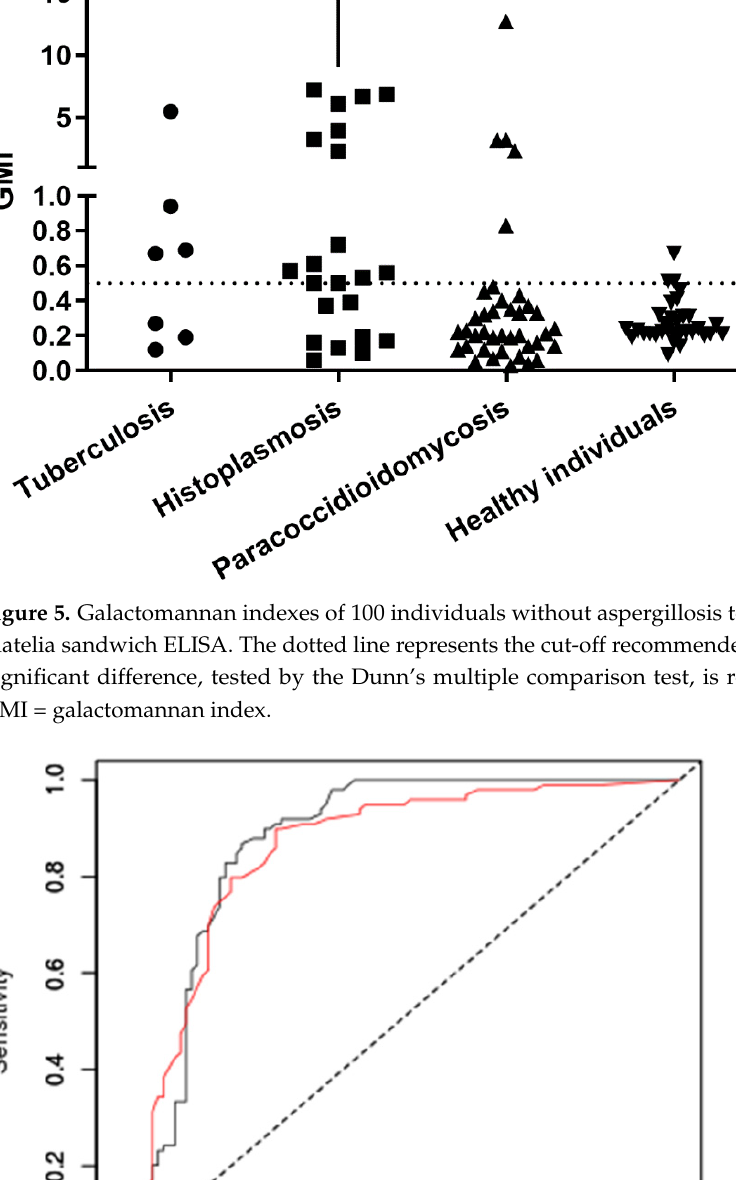
Figure 6. Receiver operator characteristic curves of the two commercial tests evaluated in this study. ELISA = Bio-Rad Platelia sandwich ELISA; LFA = IMMY s ō na AGM lateral flow assay.